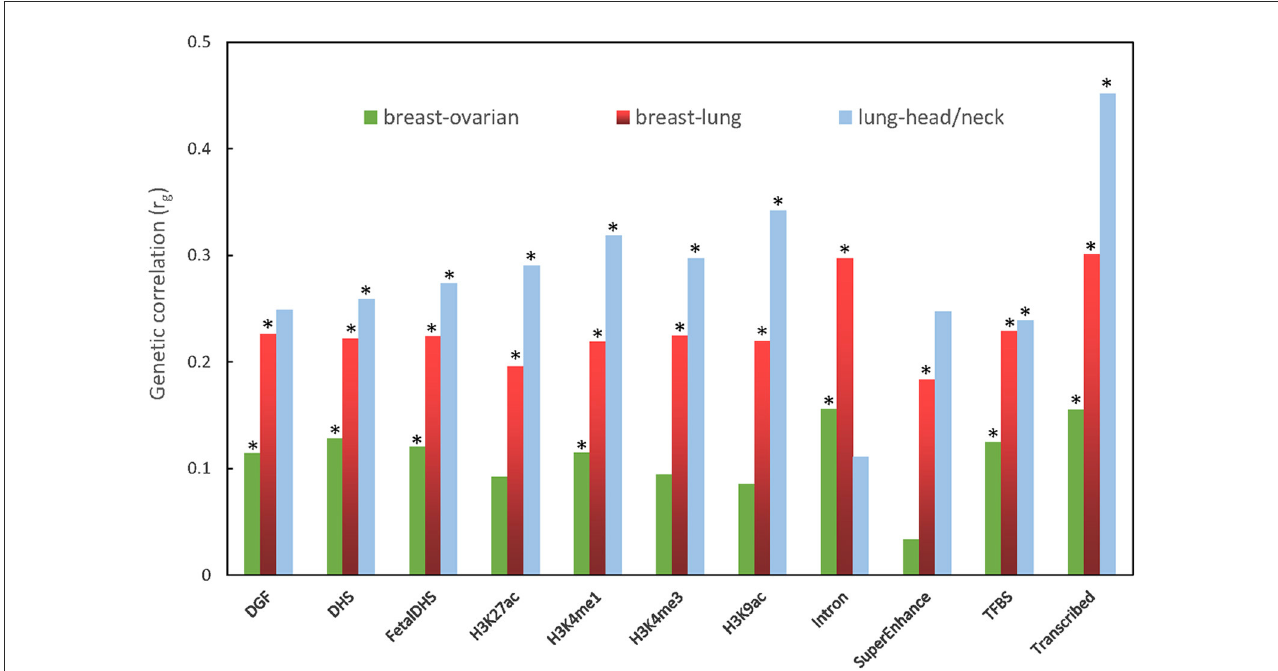
FIGURE2 Partitioned genetic correlation between breast and ovarian cancers, breast and lung cancers, and lung and head/neck cancers. The vertical axis represents the genetic correlation r g , and the horizontal axis represents 11 functional categories. The asterisk represents significance ( p <